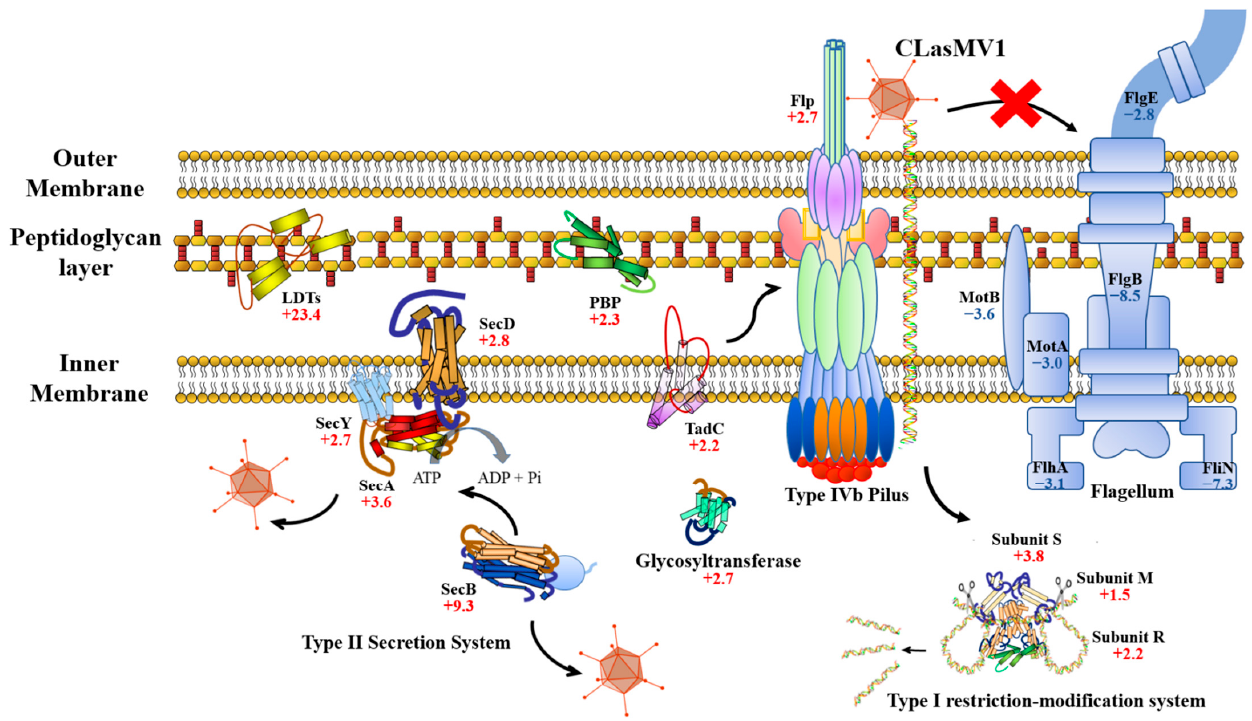
Figure 4. Selective regulation of “ Candidatus Liberibacter asiaticus” gene response to CLasMV1 phage infection. Values indicate fold change of genes expression during infection. “+”: up-regulation. “ − ”: down-regulation.